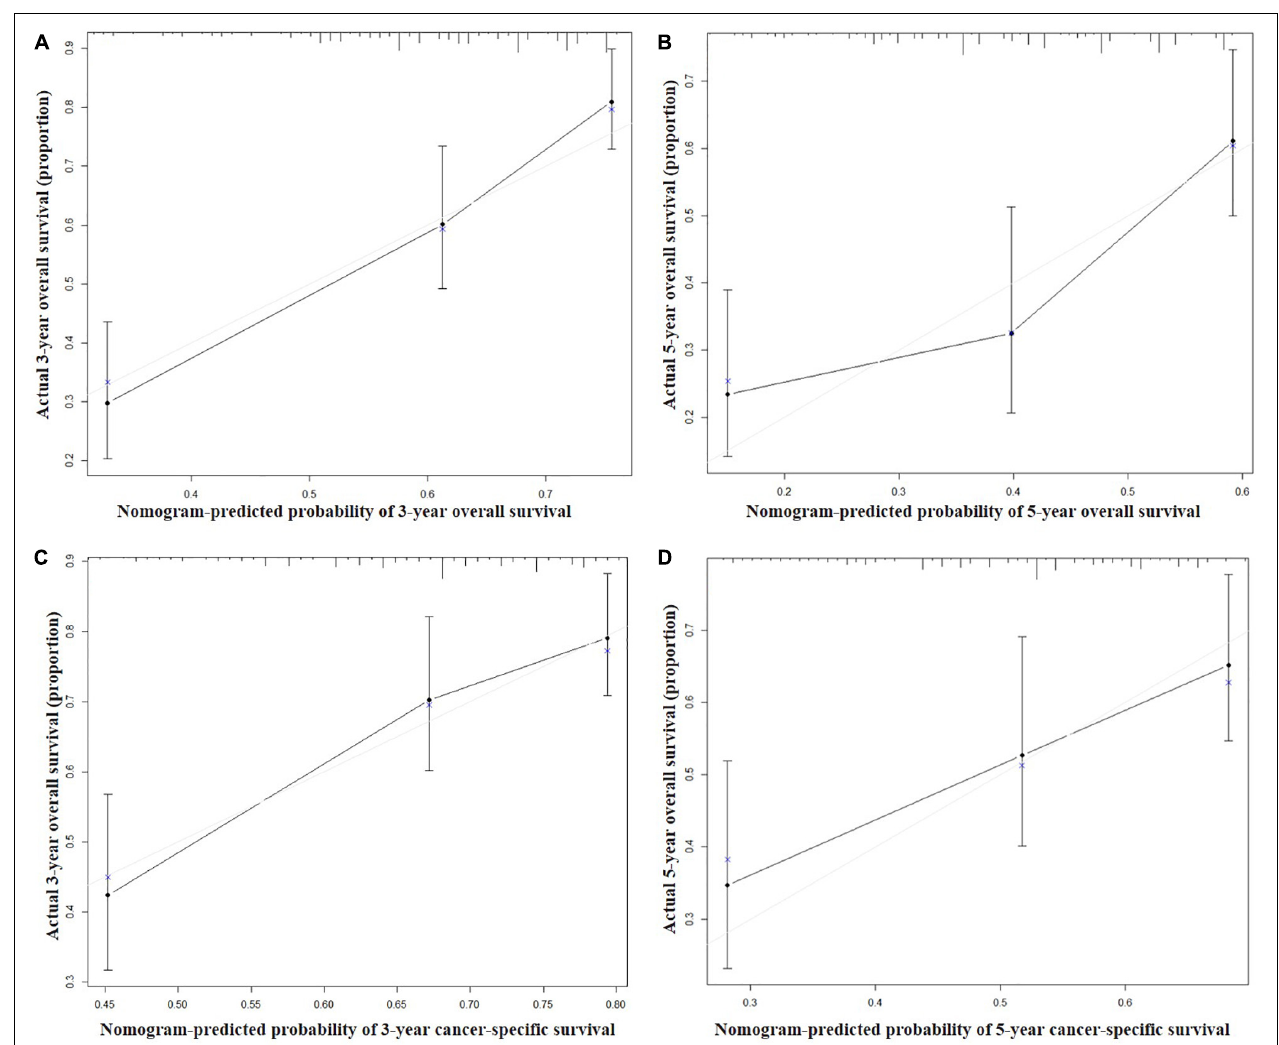
FIGURE 4 | Calibration curves for 3-year (A) and 5-year (B) overall survival; and 3-year (C) and 5-year (D) cancer-specific survival in the validation set. The X axis represents the nomogram predicted survival rate, whereas the Y axis represents the actual survival rate.